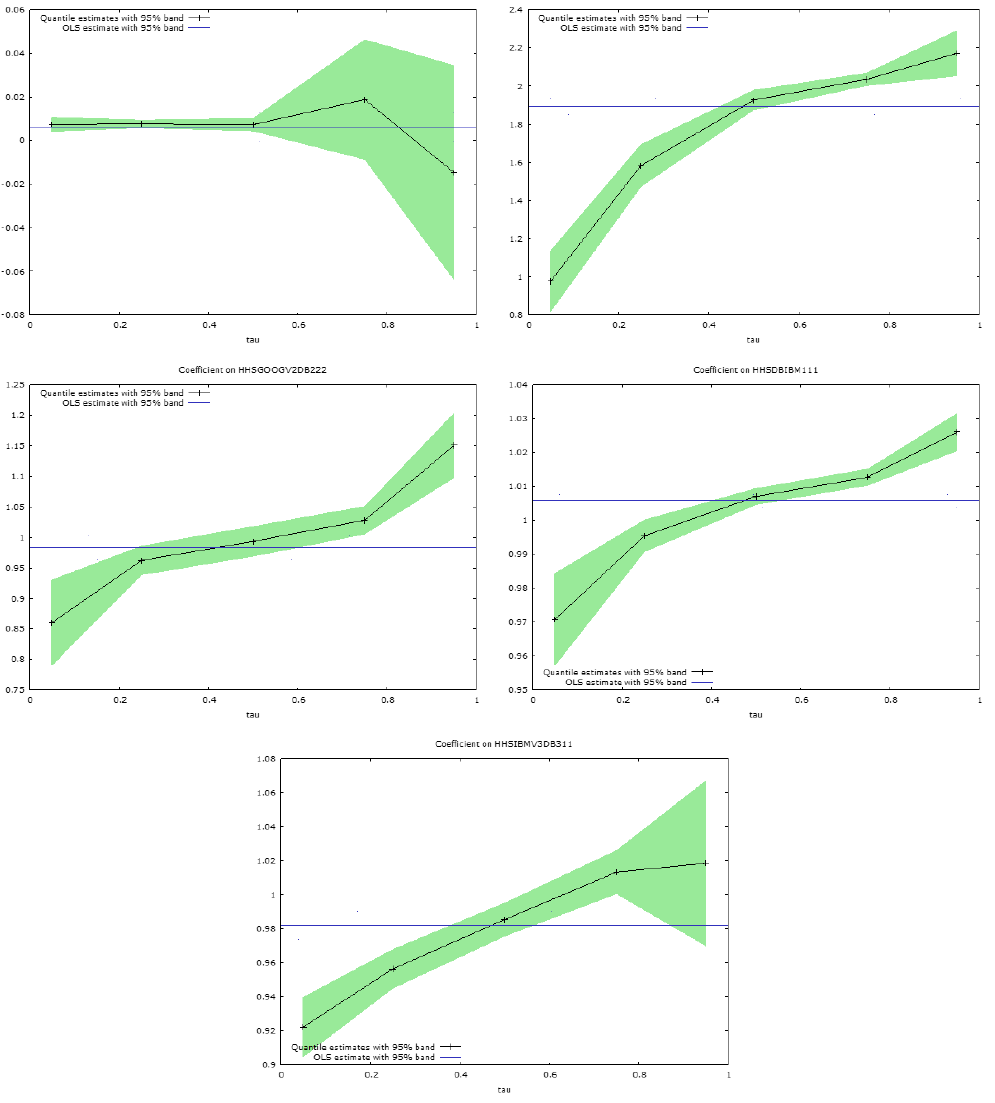
Figure 5. Quantile regression slope coefficients of conditional variance from Full BEKK regressed on DBEKK estimates (first 10